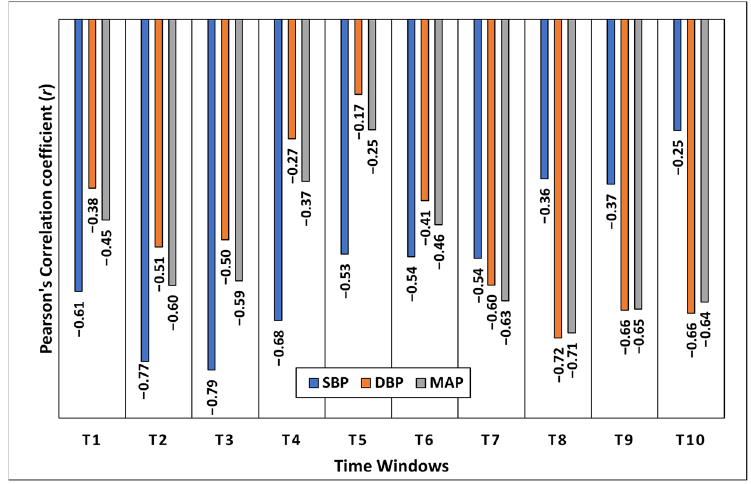
Figure 9. Correlations ( r ) of aPTT to BP at various time windows for TC ‐ 2.